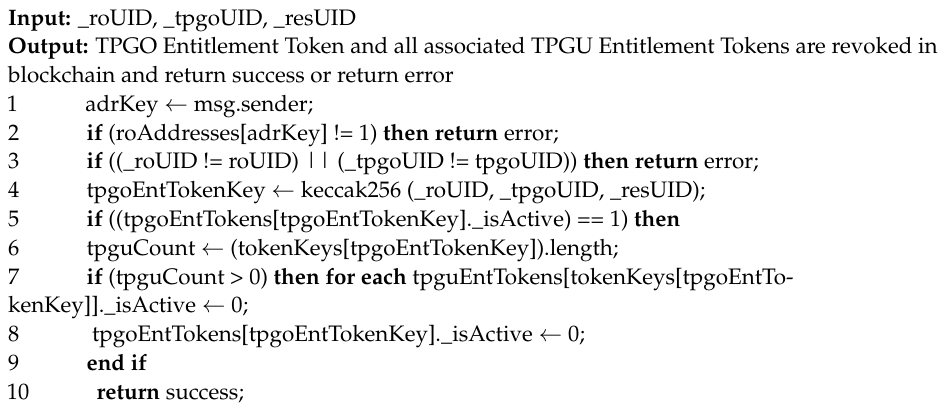
Algorithm 3: Algorithm to revoke a TPGO entitlement token in